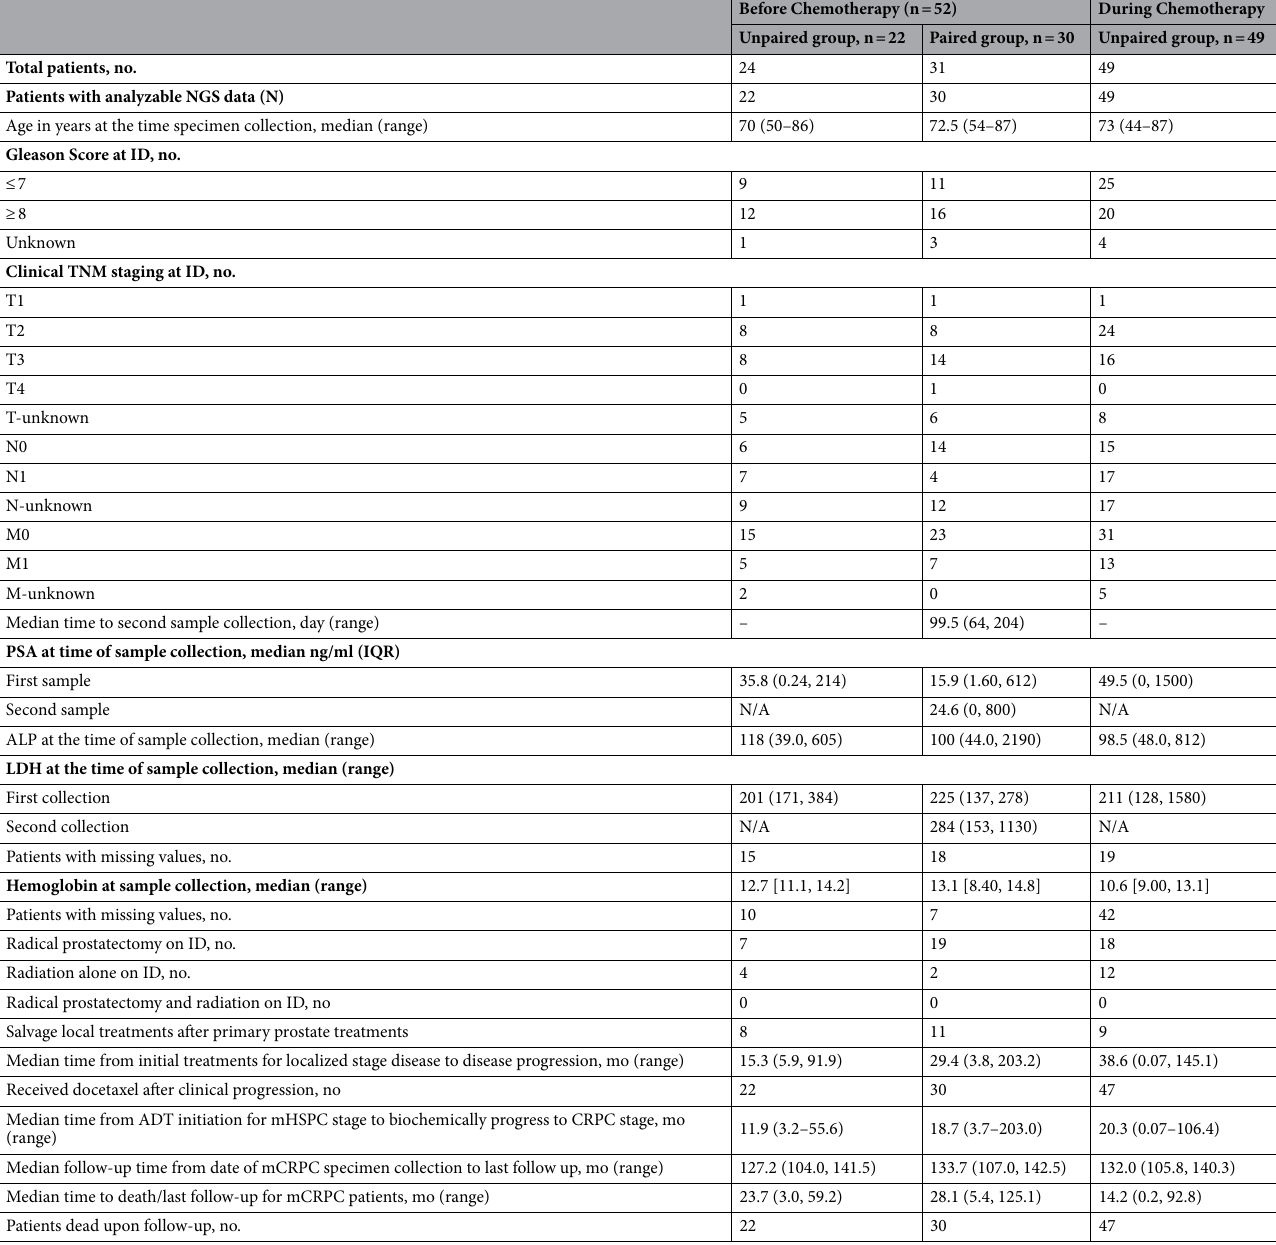
Table 1. Clinical characteristics of metastatic castrate resistant prostate cancer (mCRPC) patients undergoing chemotherapy following clinical progression on androgen deprivation therapy